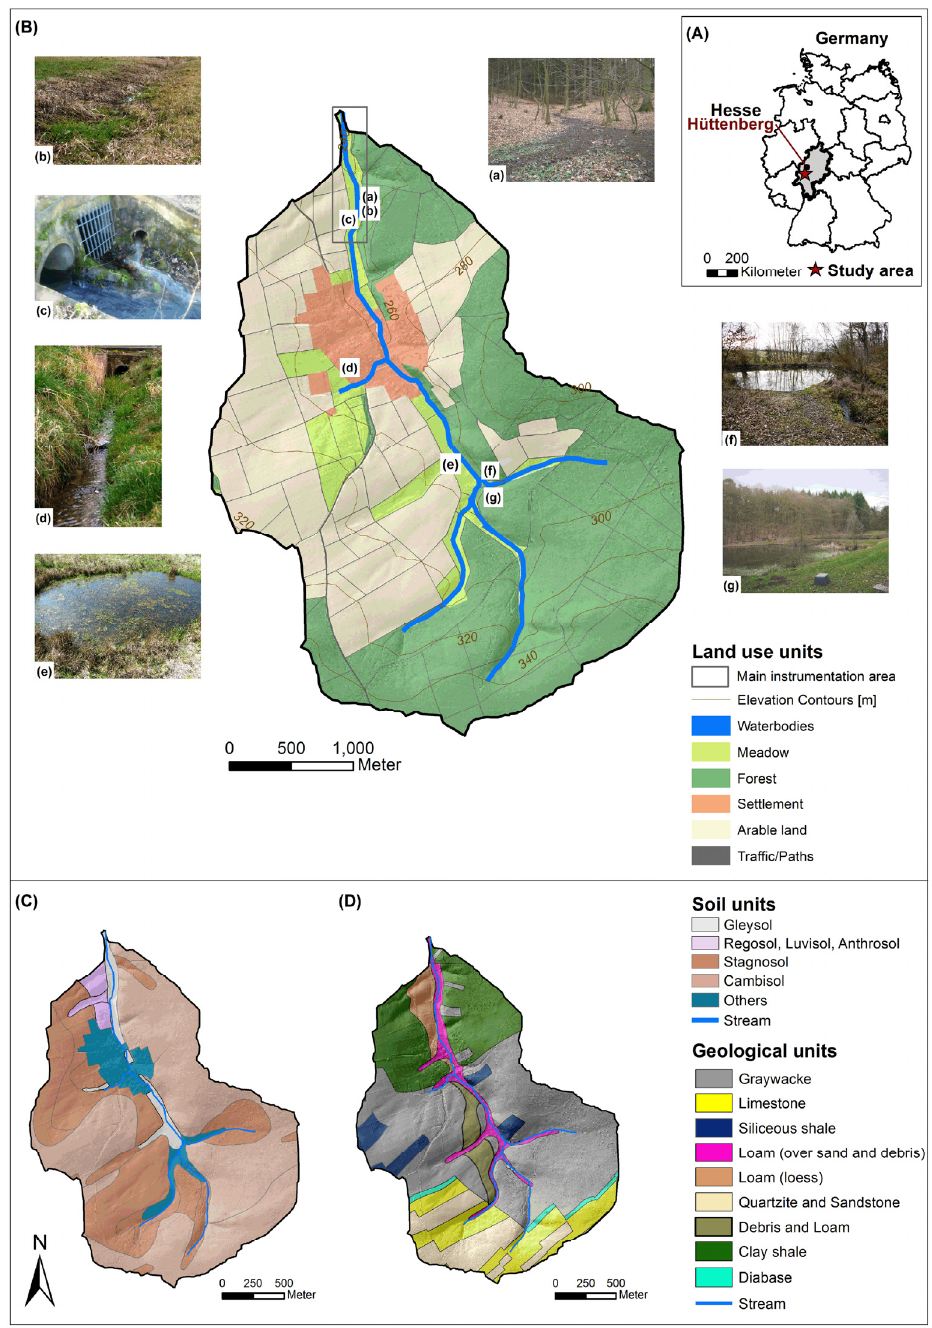
Figure 1. The maps show ( A ) the location of the Vollnkirchener Bach catchment near Hüttenberg in Germany; ( B ) the land use and major structural elements in the catchment (photos); ( C ) soils; and ( D ) geology. (Sources: soil map: HLUG [24], elevation map: HVBG [25]. Soil classes are mapped according to the World Reference Base for Soil Resources [26]). The photos depict ( a ) an ephemeral tributary; ( b ) a small perennial tributary; ( c ) a combined sewer overflow; ( d ) a channeled tributary; ( e ) a wetland; ( f ) an artificial pond; and ( g )